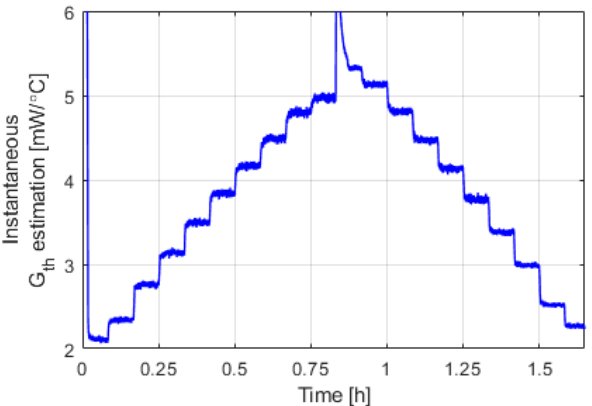
Figure 7. Time evolution, during the first experiment, of: ( a ) The sensor overheat, ( b ) total power injected in sectors.